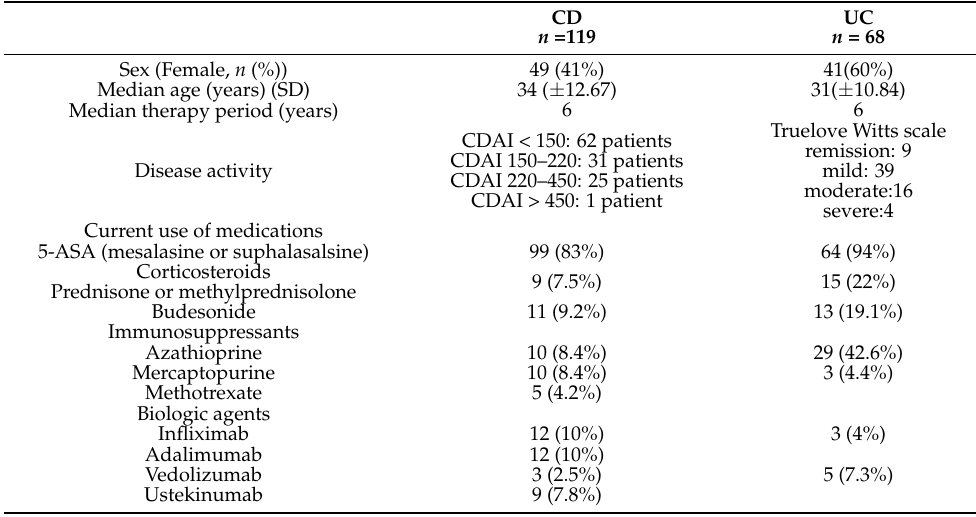
Table 1. Patient demographics at baseline.